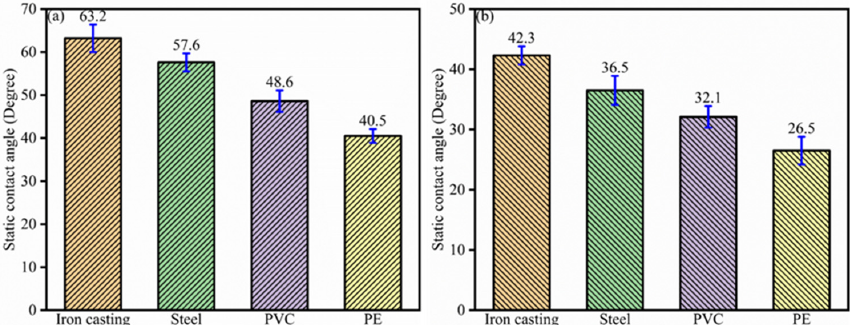
Figure 8. The static contact angles of sewage water drops onto the iron casting, steel, PVC, and PE ( a ) without vibration; ( b ) with 300 Hz vibration. ( a ) without vibration; ( b ) with 300 Hz